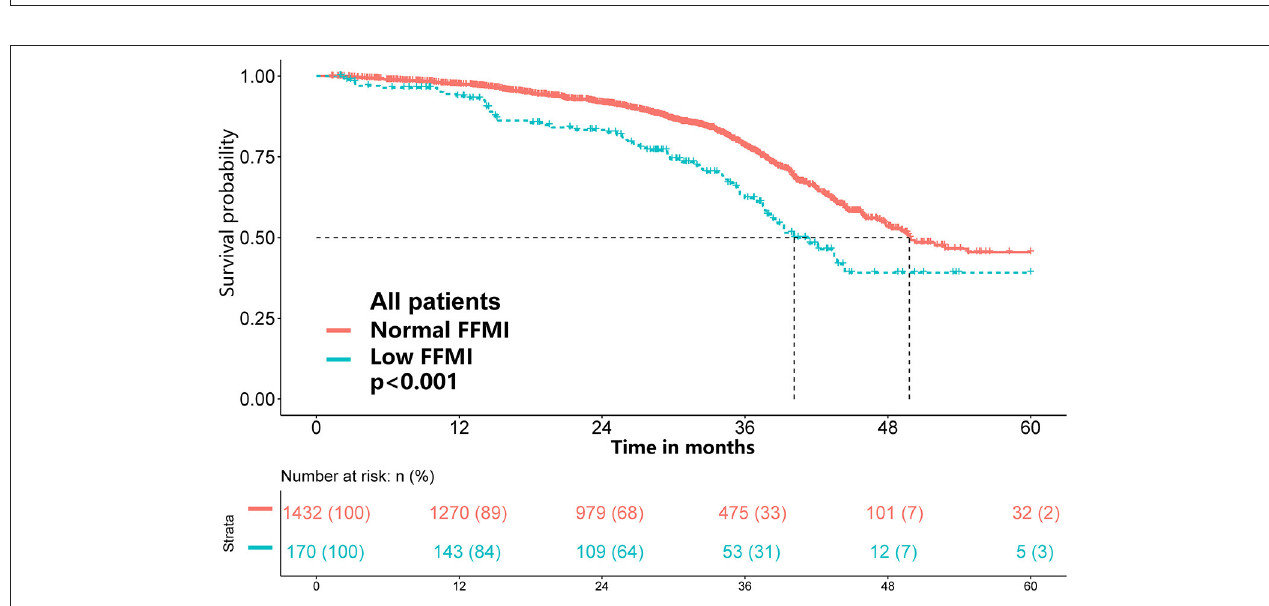
FIGURE 2 | Results of the Kaplan-Meier survival analysis stratified by FFMI in cancer patients with normal/high BMI.